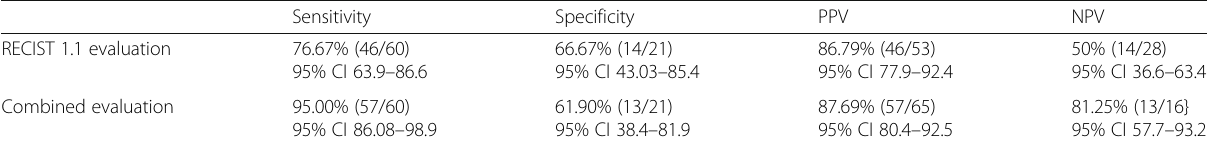
Table 7 Comparison between the evaluation of response based on RECIST 1.1 and the evaluation of response based on the